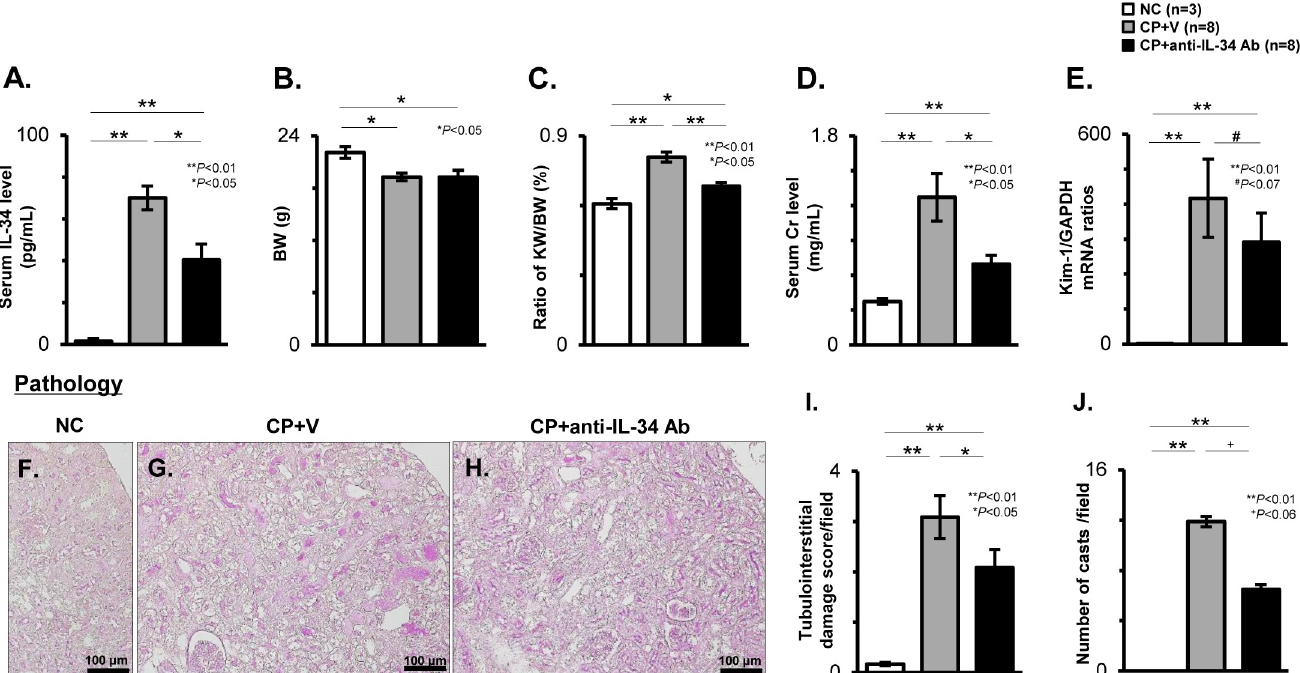
Fig 4. Biochemical parameters and renal histological findings in CP-N mice. The serum IL-34 levels as evaluated by ELISA ( A ), the body weight (BW) ( B ), and the ratios of the kidney weight (KW) to the BW ( C ) among the study groups. The serum Cr levels determined by the Cr assay kit ( D ) among the study groups. The mRNA levels for Kim-1 among the study groups ( E ). Values were normalized to the GAPDH transcript, and are expressed as the relative ratio. Representative photos of kidney tissues stained with PAS in a NC mouse ( F ), CP+V mouse ( G ), and CP+anti-IL-34 Ab mouse ( H ). Original magnification, 200 × . Quantification of the tubulointerstitial damage score per field ( I ), and the number of casts per field ( J ) among the study groups. Data are expressed as the mean ± SEM. The Mann- Whitney U test was used for statistical analysis.